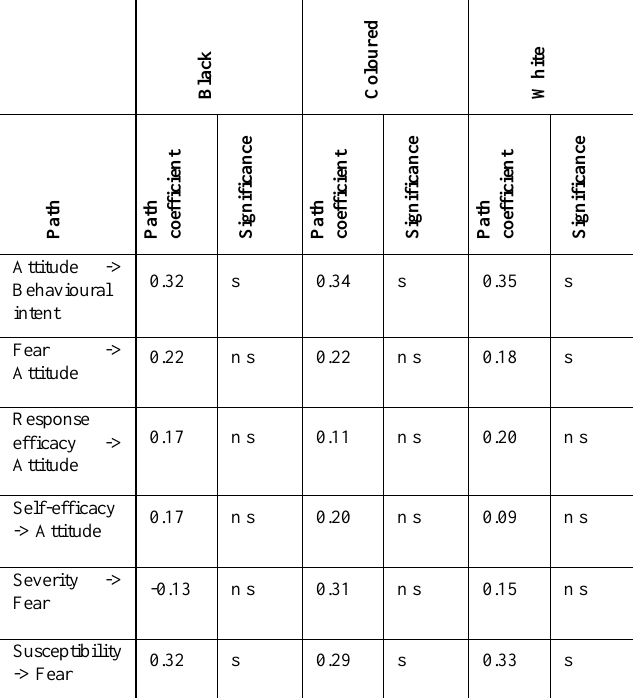
Table 3: PLS path analysis: Culture/racial